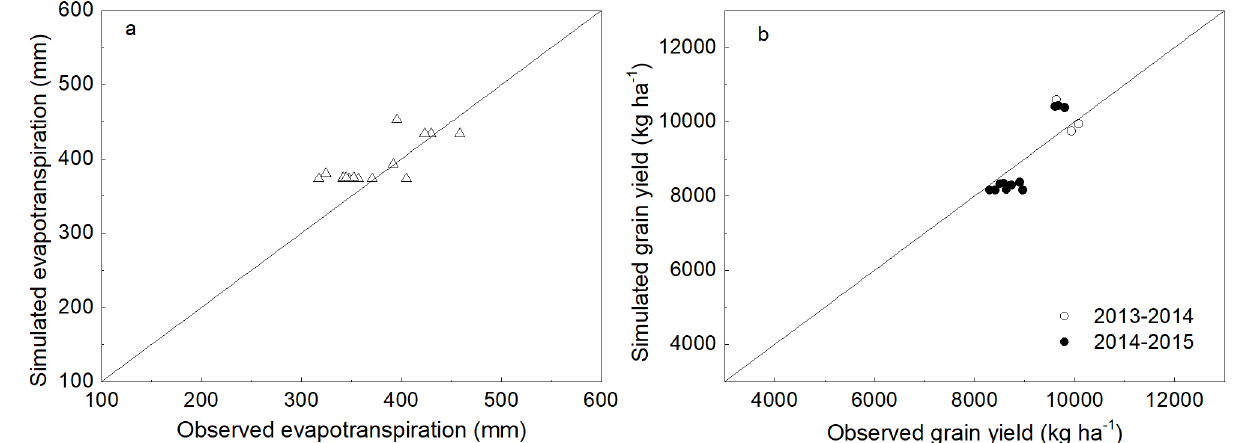
Fig 3. Validation results of the CERES-wheat model for evapotranspiration (a) and grain yield (b).